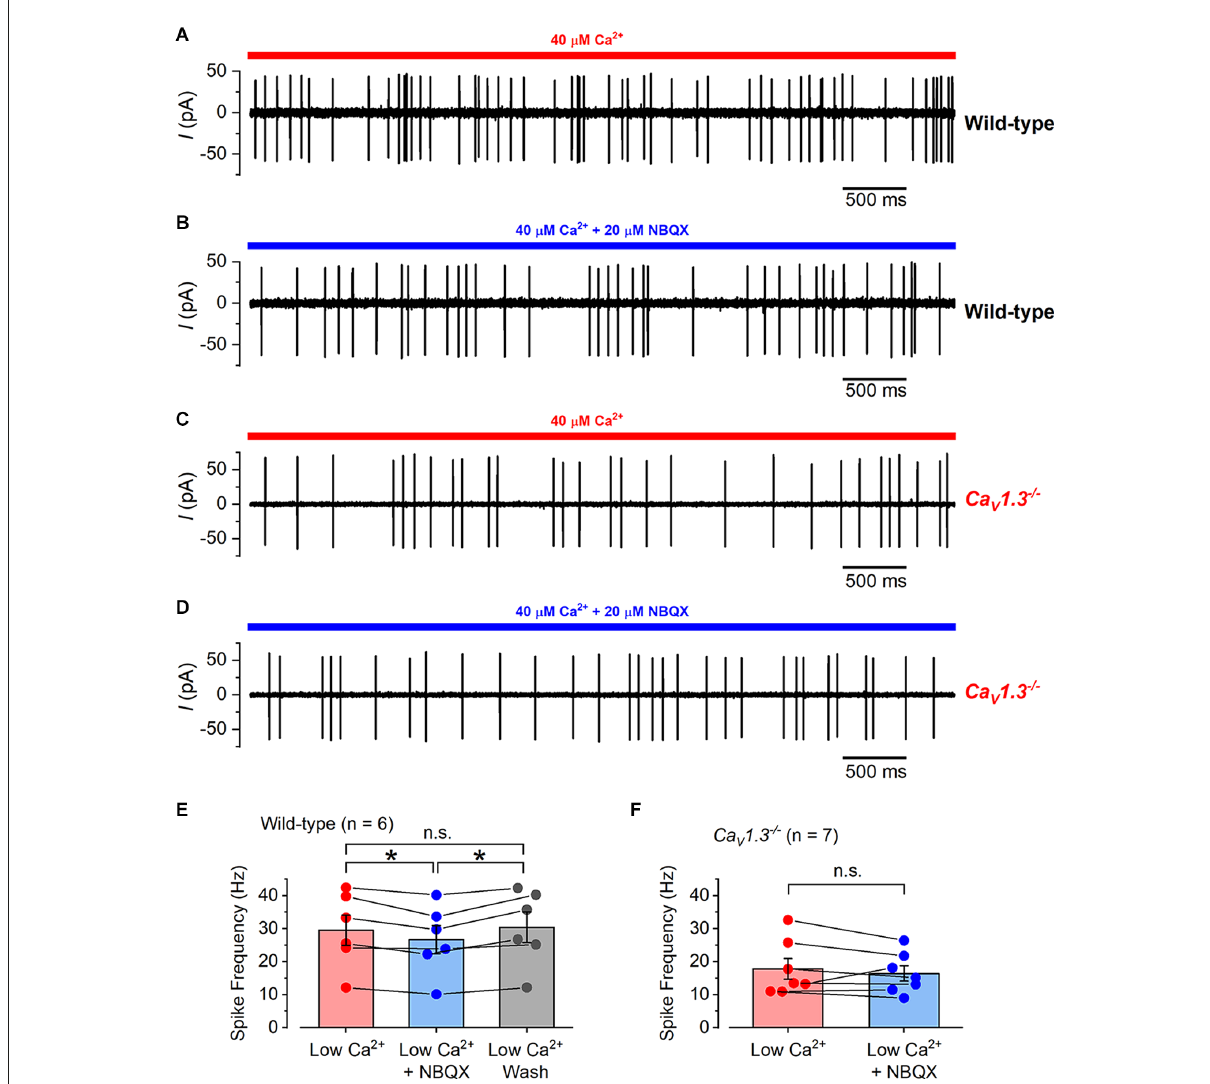
FIGURE8 The effect of NBQX application on calyx spiking activity in wild-type and Ca V 1.3 − / − mice. (A) A typical example of a cell-attached recording from a calyx in a wild-type mouse utricle where spikes were elicited by the local perfusion of 40 µ M Ca 2+ (indicated by the red bar). (B) Cell-attached spiking activity from the same calyx in (A) but in the presence of 20 µ M NBQX together with 40 µ M Ca 2+ (indicated by the blue bar). (C) Cell-attached spiking activity from a calyx of a Ca V 1.3 − / − mouse in the presence of 40 µ M Ca 2+ . (D) Spiking activity from the same calyx in (C) in the presence of 20 µ M NBQX together with 40 µ M Ca 2+ . (E) The average cell-attached spike frequency in wild-type calyces in low Ca 2+ (40 µ M; red), low Ca 2+ with NBQX (20 µ M; blue), and after low Ca 2+ wash (gray). The columns show the average values with error bars and the individual data points are shown as scatter plots on top with connecting bars to the linked values from the same cell. The values in NBQX were slightly but significantly smaller than those in low Ca 2+ and washout ( P = 0.03 and P = 0.02, respectively; repeated measures one-way ANOVA Tukey post-test). There was no significant difference between the values in low Ca 2+ compared to washout ( P = 0.17). (F) The average cell-attached spike frequency in Ca V 1.3 − / − calyces in low Ca 2+ (40 µ M; red), and low Ca 2+ with NBQX (20 µ M; blue). The values are shown as in (E) and there was no significant difference between the